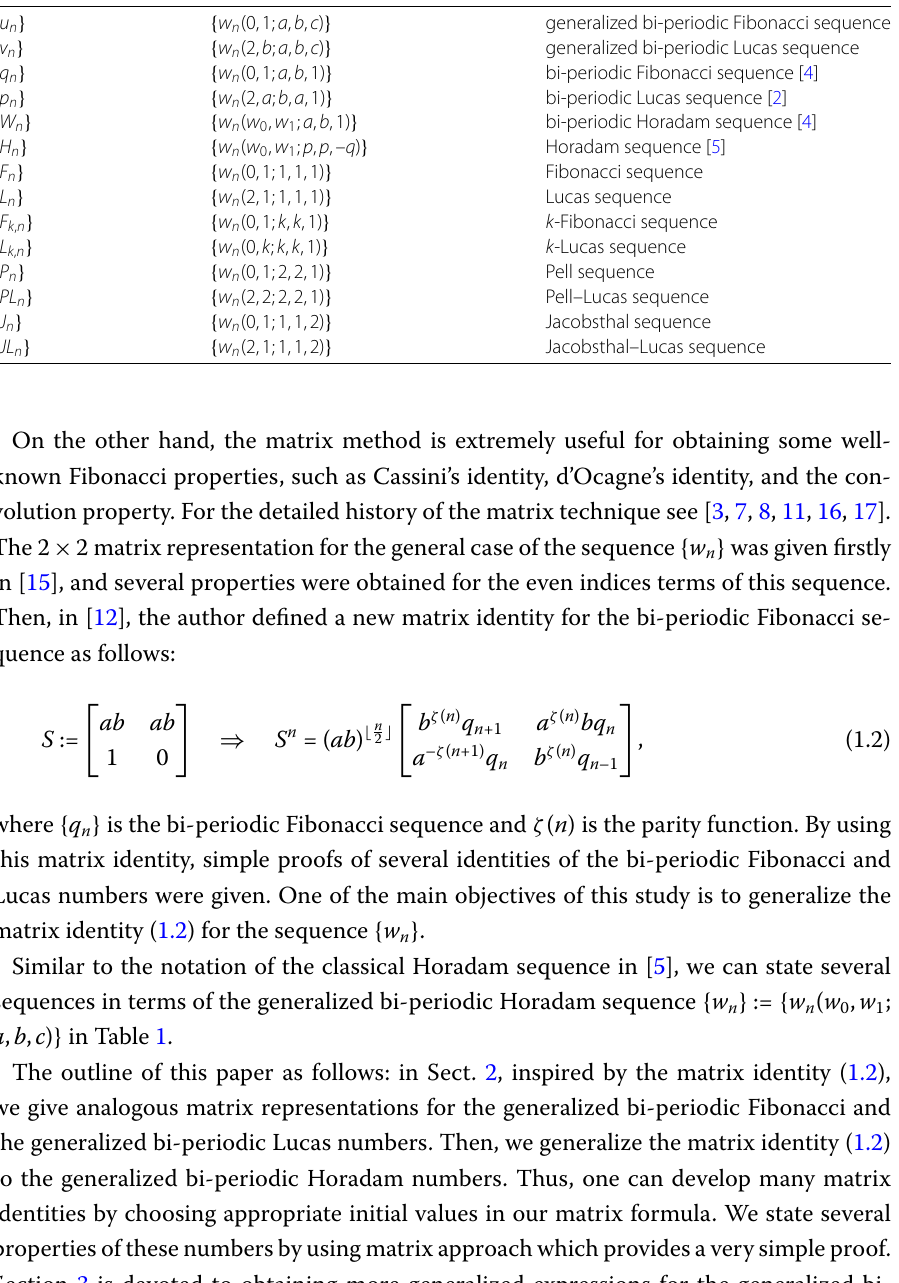
Table 1 Special cases of the sequence { w n } { w n